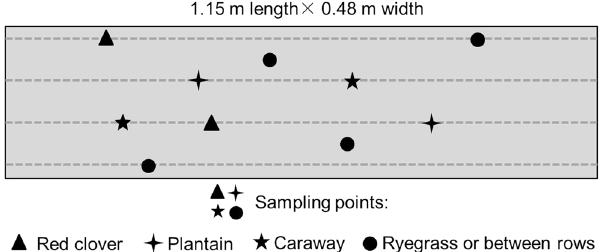
Figure 1. Root sampling in August in the grassland experiment. It is illustrated with a perennial ryegrass-red clover mixture including plantain and caraway. Dashed horizontal lines represent crop rows and symbols refer to sampling points for the different plant species ( n = 2 for each species and for between-row samples). For red clover, caraway and plantain, each soil core (0–50 cm) for root sampling was taken on an individual